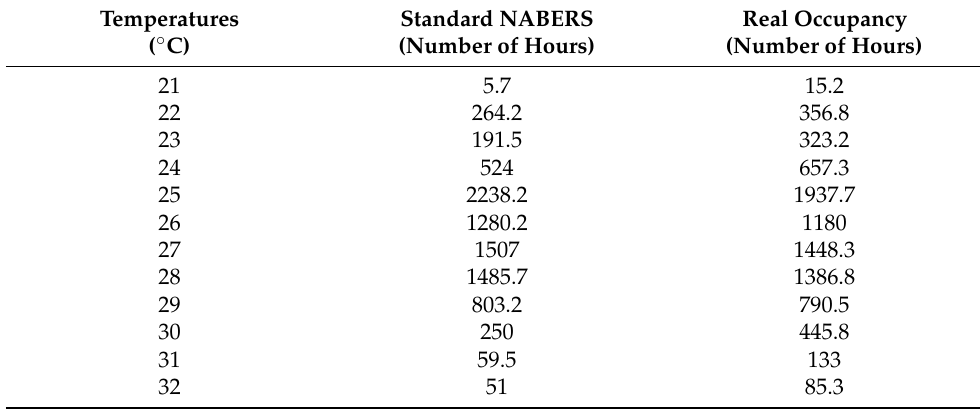
Table 5. Number of hours on a year at different operative